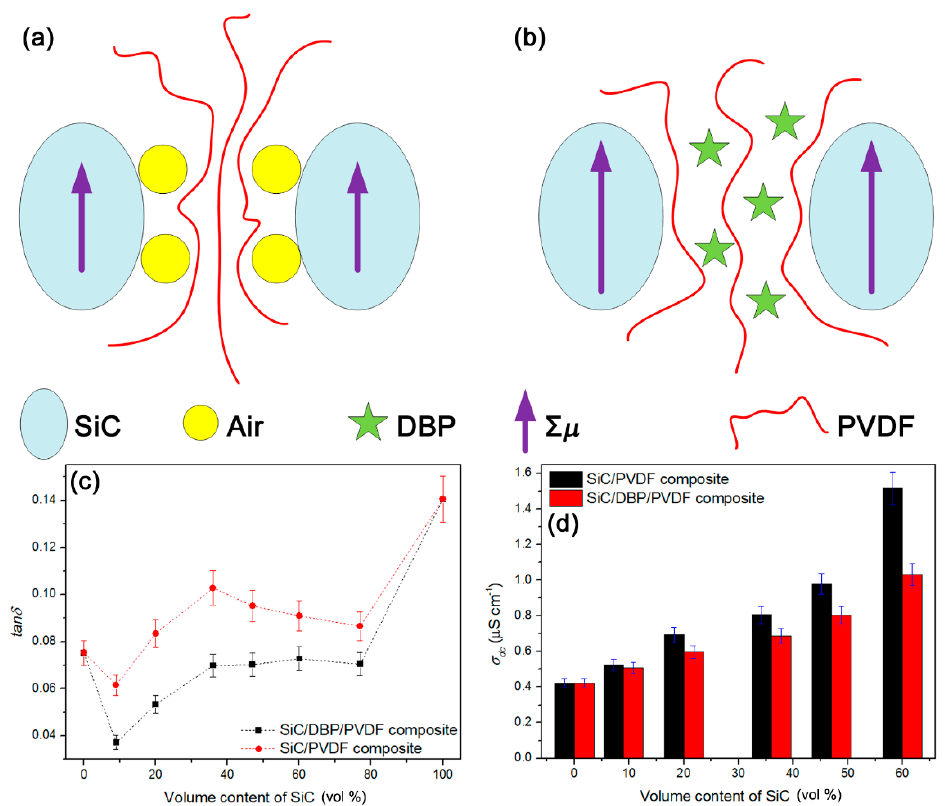
Figure 6. ( a ) Diagram model shows a low compact degree for the interface zones of the binary composites; ( b ) diagram model shows a high compact degree for the ternary composites; ( c ) the reduction of dielectric loss at 1 kHz for the ternary composites compared with the binary composites; and ( d ) the reduction of dc conductivity at 1 kV cm − 1 for the ternary composites compared with the binary composites.